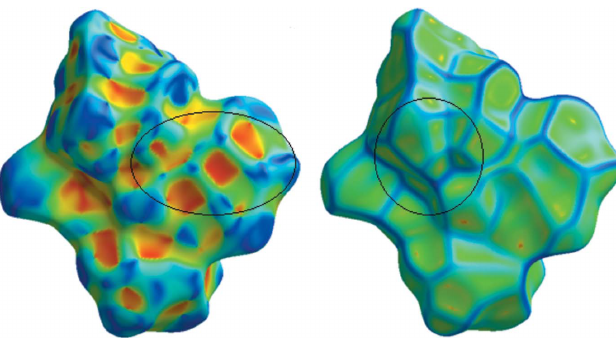
Figure 5 Hirshfeld surface mapped over shape-index for the title